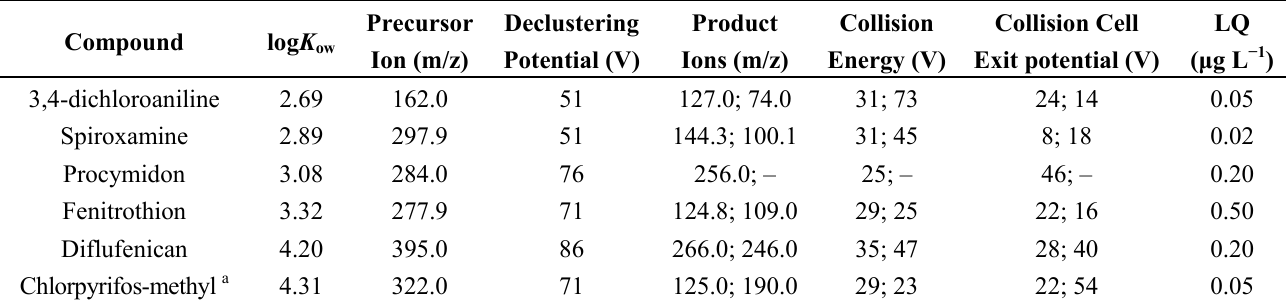
Table 2. Multiple reaction monitoring conditions for MS/MS analysis and limits of quantification of the selected pesticides (from Margoum et al.